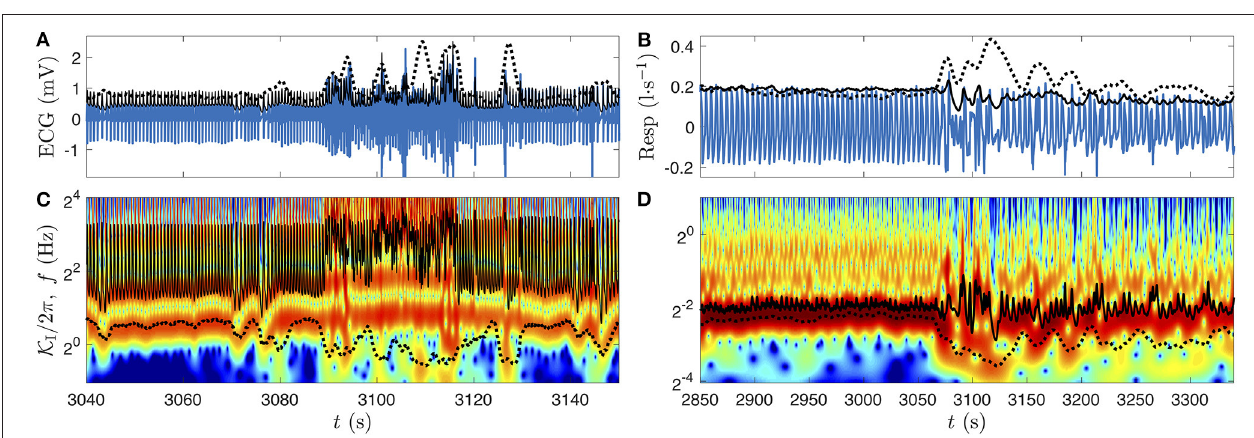
FIGURE 6 | Illustration of the complex rate of the ECG (A,C) and of the respiration signals (B,D) , from subject slp04 of slpdb near the transition from deep sleep stage to wake phase represented in Figures 4 , 5 . In (A,B) , the physiological recording is plotted with a blue line, the amplitude estimated using K R ( t ) (Equation 12) is the black line, and the alternative estimated amplitude is the black dotted line (see details below). (C,D) Color-coded amplitude of the signals CWT, with their frequency modulations estimated as the imaginary parts of the complex rates K I / 2 π (Equation 8) (black lines), and the alternative estimations (black dotted line). In each panel, the alternative estimation (black dotted line) aims at reducing the non-linearity-induced oscillations (see text and Supplementary Figure 2 ). The Grossmann wavelet of quality factor Q 5 is used for the CWTs. The frequency ranges shown in (C,D) are the ones used for the complex rates computation. = illustration, we apply this method to the EEG, ECG, and ( Figure 5 and Supplementary Figure 2 ) is reproduced respiration signals of subject slp04 from the database slpdb easily for the respiration rhythm, yielding two (see Figures 6 , 7 ).